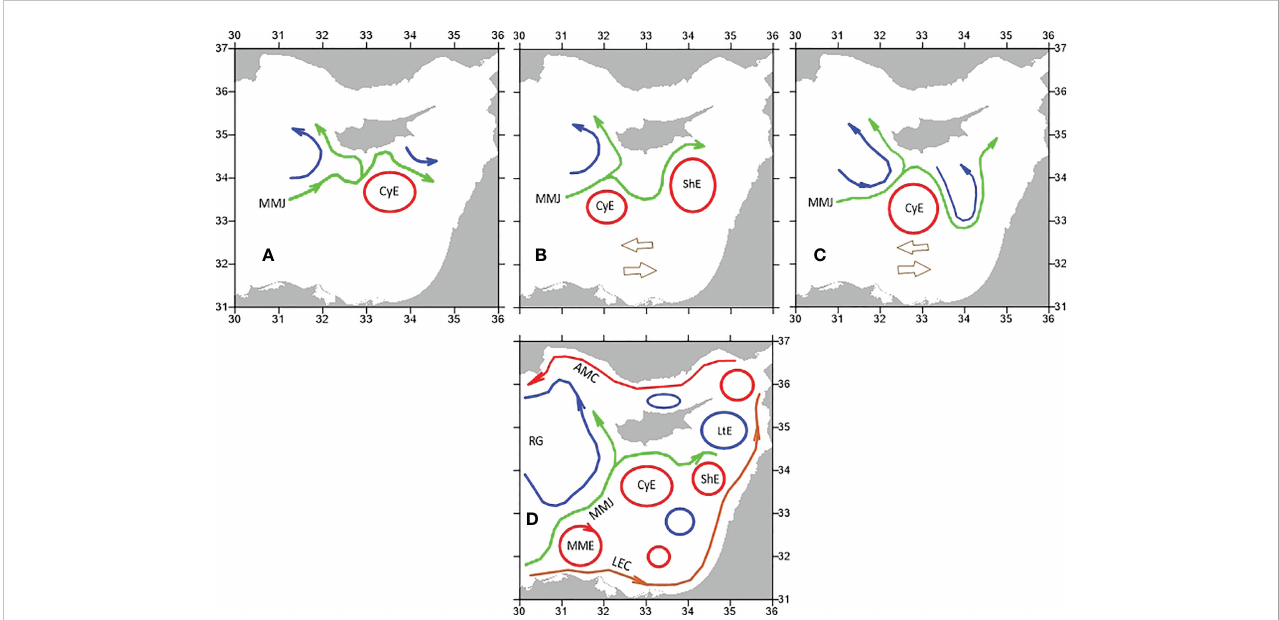
FIGURE 14 Schematic of the main fl ow features in the SE Levantine from 1995-2015 and the overall circulation based on in-situ data and downscaling numerical simulations. The three upper panels correspond to the three periods in Figure 5: (A) 1996-1999, (B) 2001-2007, and (C) 2009-2012 and the lower panel shows (D) summary of main features for the entire twenty year period. Anticyclonic eddies are shown in red (CyE, Cyprus Eddy; ShE, Shikmona Eddy; MME, Mersa Matruh Eddy), cyclonic eddies in blue (LtE, Lattakia Eddy; RG, Rhodes gyre), the MMJ in green, and the along the shelf-slope currents: LEC, Libyan-Egyptian Current in brown and AMC, Asia Minor Current in